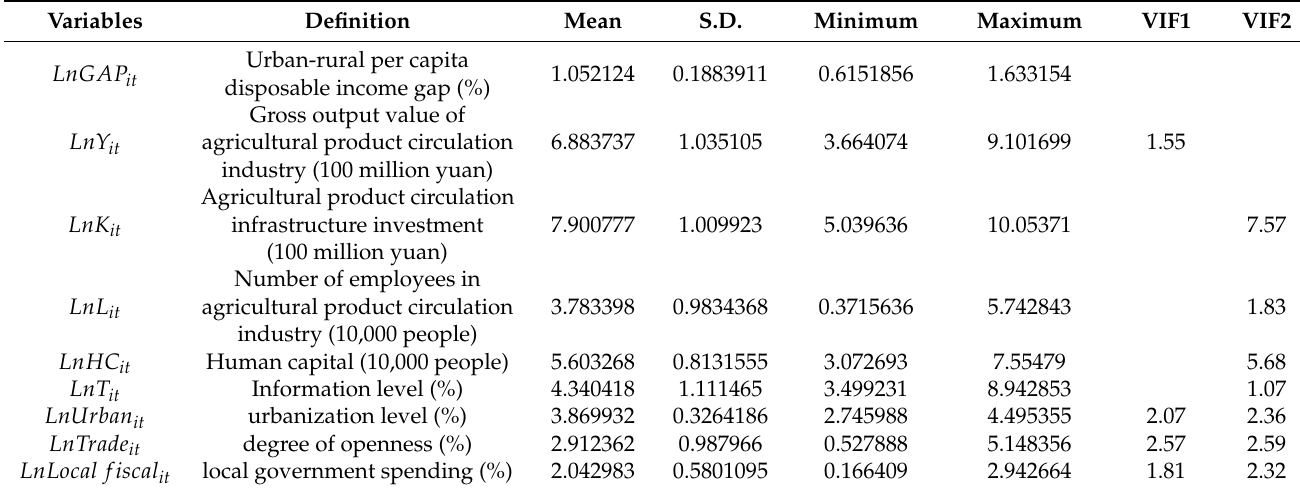
Table 2. Definition and descriptive analysis of variable